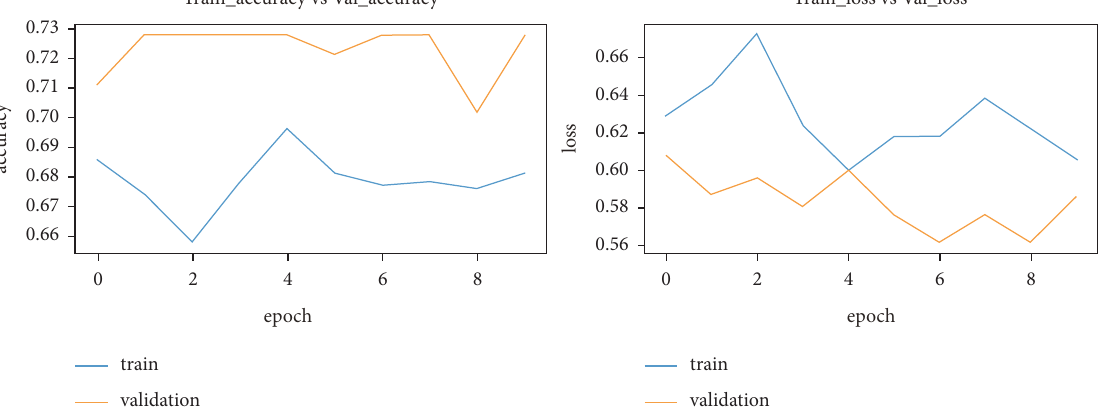
Figure 9: Training accuracy and val_acc Vs training loss and val_loss of EfficientNetB0.